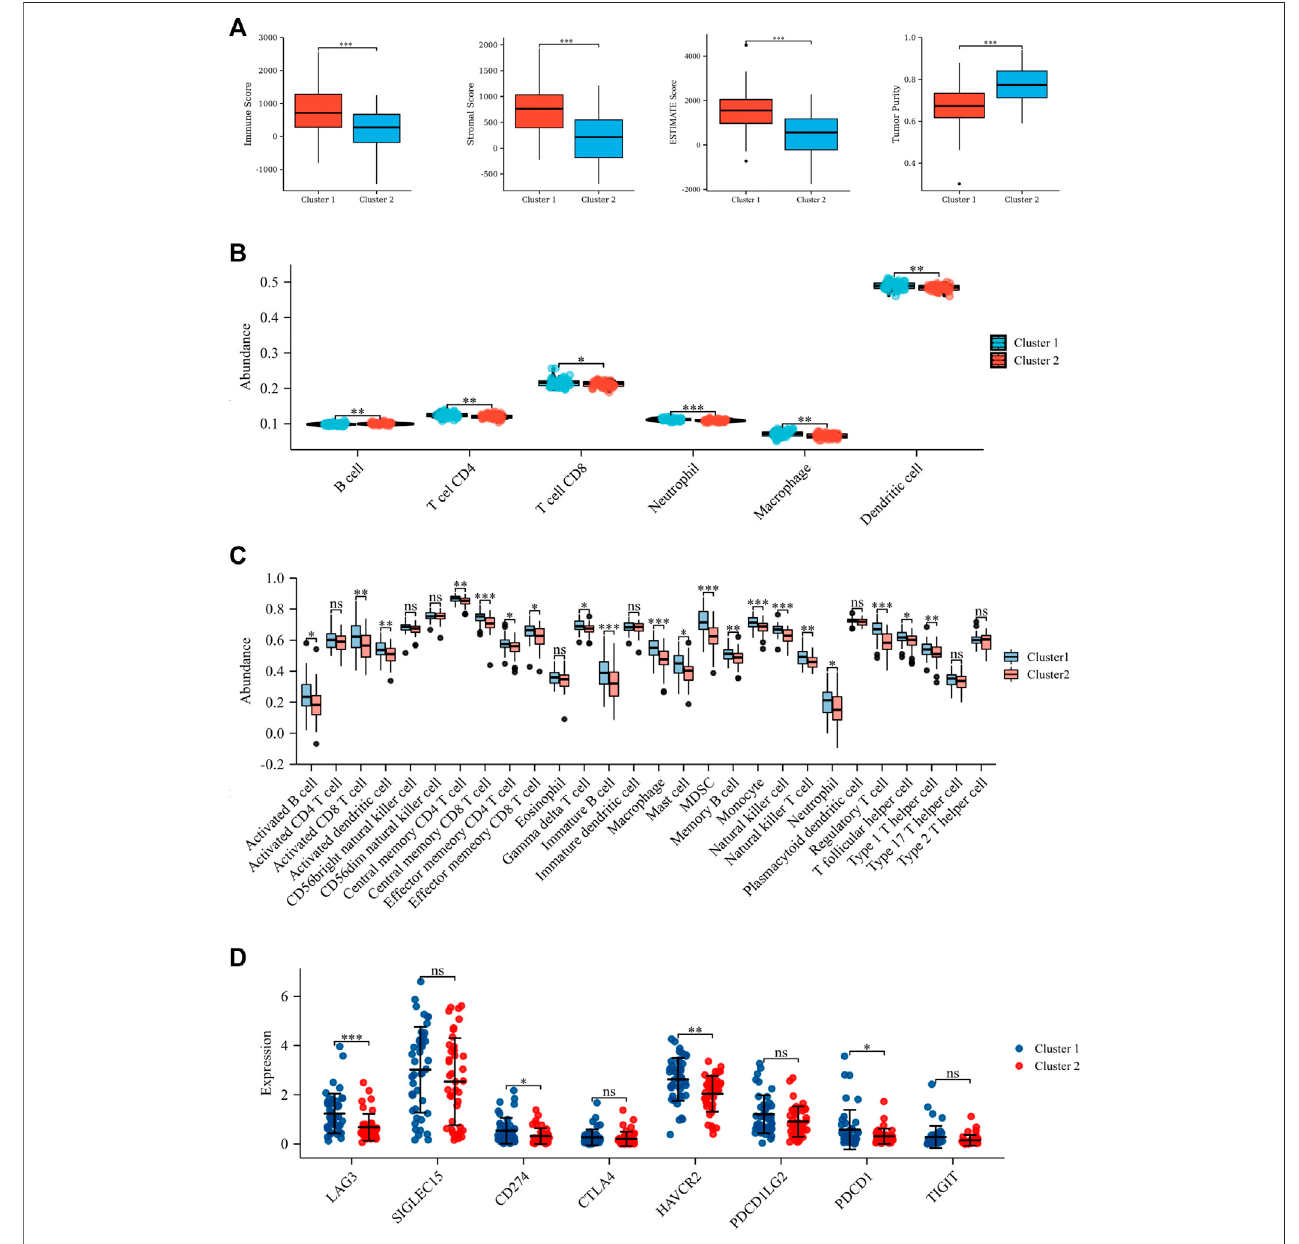
FIGURE 2 | Tumor microenvironment in the two subtypes. (A) Stromal score, immune score, ESTIMATE score, and tumor purity based on ESTIMATE algorithm. (B) SiximmunecellabundanceassessmentsbytheTIMERalgorithm. (C) Twenty-nineimmunecellabundanceassessmentsbythessGSEAalgorithm. (D) Differencesin immune checkpoints between the two subtypes. * p < 0.05; ** p < 0.01; *** p <